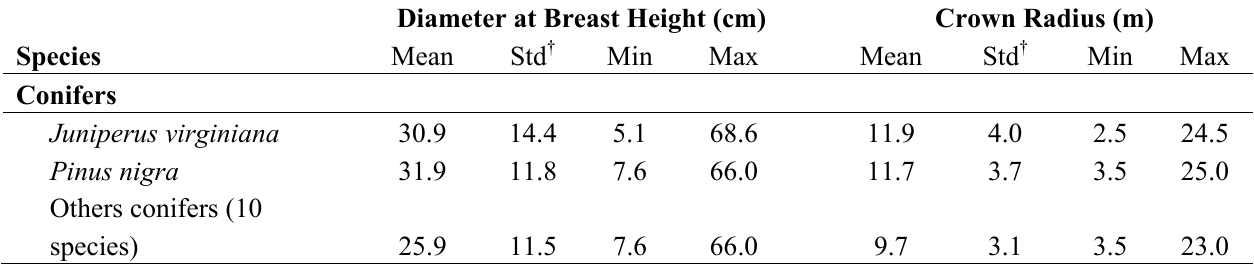
Table 6. Statistics for diameter at breast height and crown radius of the trees measured in the field.